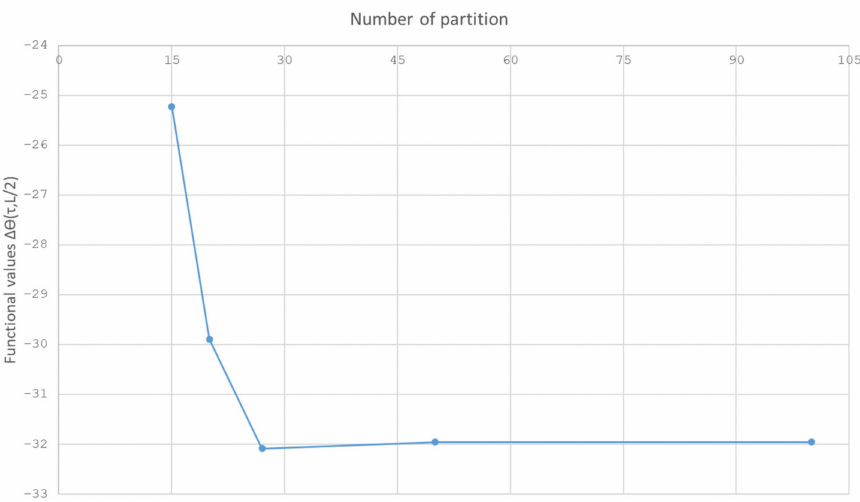
Figure 1. Dependence of the function values ∆Θ ( τ , L /2) on the number of partitions.